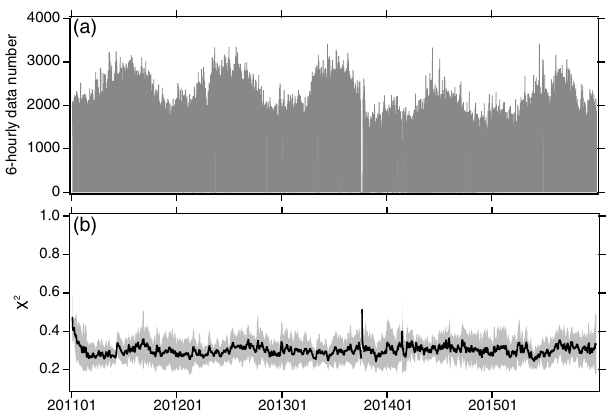
Figure 2. (a) Time series of the number of 6-hourly NRL-UND MODIS AOD data. (b) Time series of the 5-day moving average of the chi-square value ( χ 2 ; thick black line) and its standard deviation (gray